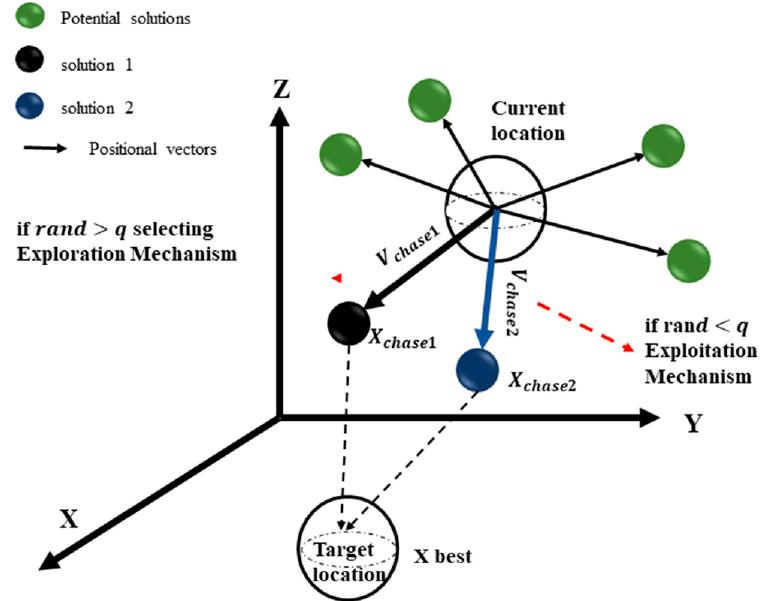
Figure 3. Graphical depiction of orcas driving the prey [37].